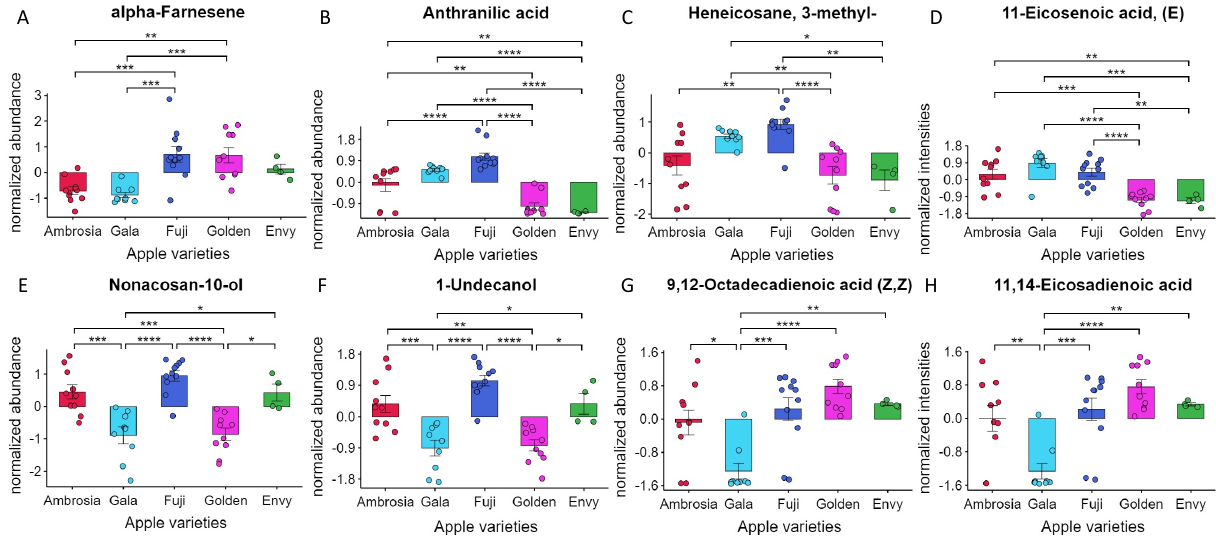
Figure 4. Boxplots of apple varieties markers. Relative abundances of alpha-Farnesene ( A ), Anthranilic acid ( B ), Heneicosane, 3-methyl- ( C ), 11-Eicosenoic acid ( D ), Nonacosan-10-ol ( E ), 1-Undecanol ( F ), 9,12-Octadecanoic acid (Z,Z) ( G ) and 11,14-Eicosadienoic acid ( H ) of the apple metabolome of Ambrosia (red dots), Envy (green dots), Fuji (blue dots), Gala (light blue dots), and Golden (purple dots). p -value < 0.05 = *, p -value < 0.01 = **, p -value < 0.001 = ***, p -value < 0.0001 = ****.